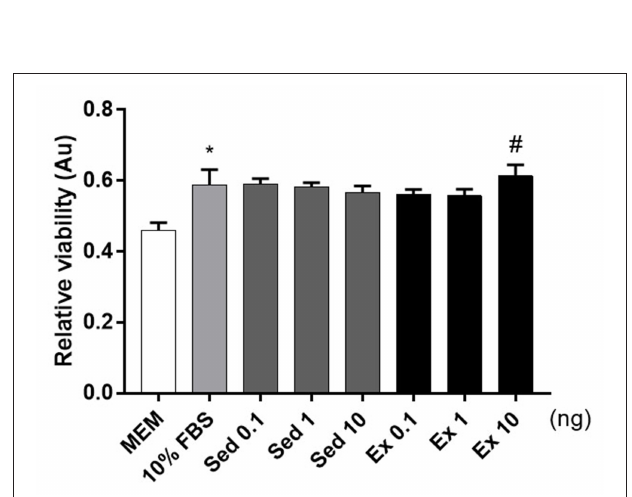
FIGURE 3 | Changes in the EV miRNA profiles after 4 weeks of voluntary wheel exercise. (A) A bioinformatic schematic. (B) The target genes predicted by functional clustering. Each sedentary, exercise group animal number was 6.